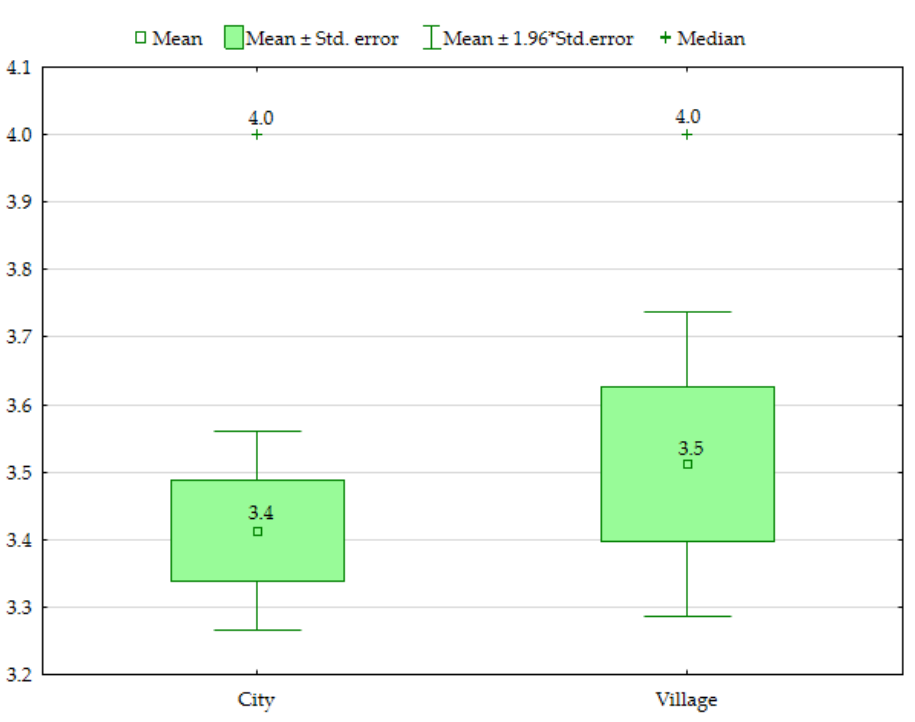
Figure 7. Gender and the assessment of energy compensation. Storage of production by day, receiv- ing at night. Source: Own elaboration based on the conducted research, n = 444.